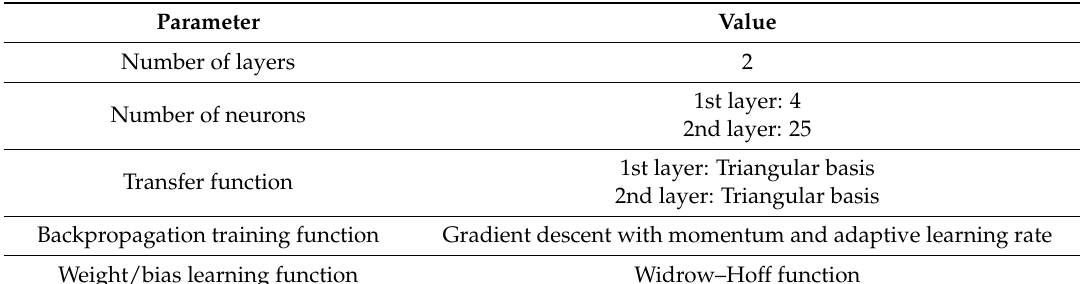
Optimal parameters of the MLP neural network obtained in the artificial neural network–genetic algorithm (ANN-GA) hybrid approach for the classification of the ripening stages of the apples.